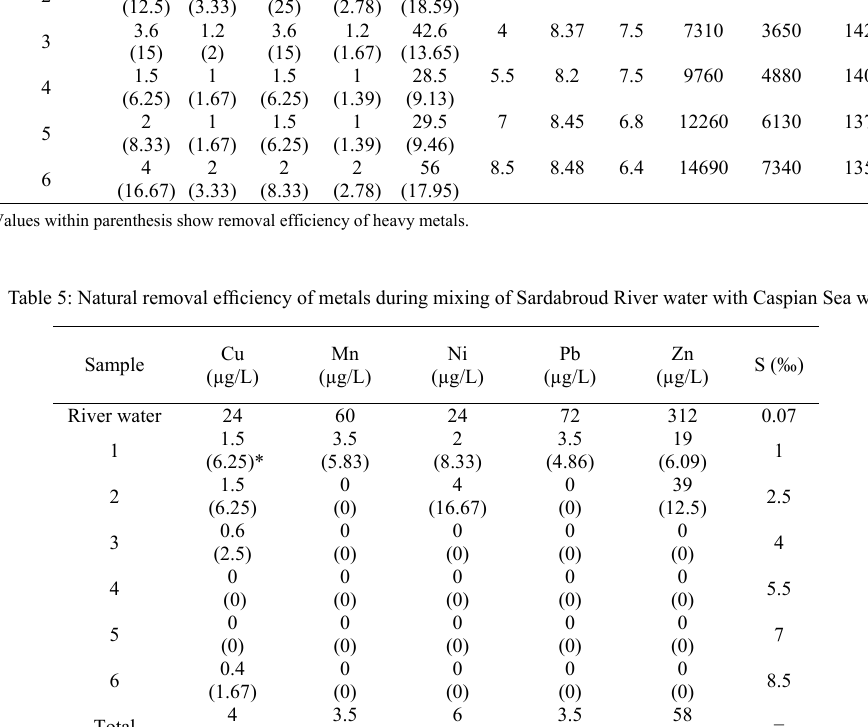
Table 4: Laboratory removal efficiency of metals during mixing of Sardabroud River water with Caspian Sea water